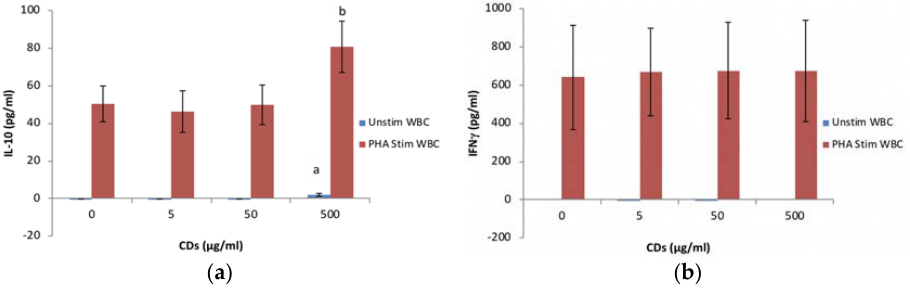
Figure 6. The acquired immune system biomarker expression levels of whole blood cell cultures exposed to CDs in the absence or presence of phytohaemmagglutinin (PHA): ( a ) IL ‐ 10 expression levels and ( b ) IFN γ expression levels. Data represents mean ± SD with n = 4. Significance demarcated by a: significantly different ( p < 0.001) compared to 0 μ g/mL CD control, b: significantly different ( p < 0.008) compared to PHA stimulated 0 μ g/mL CD control.